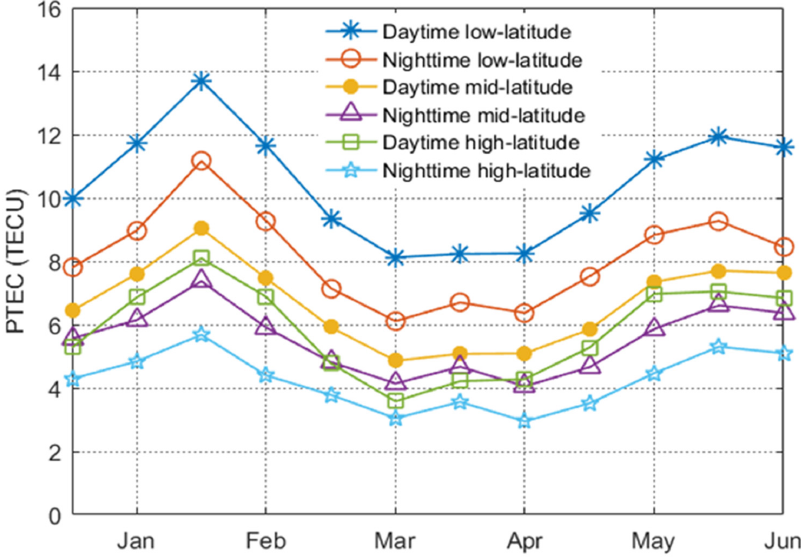
Figure 10. Monthly mean daytime and nighttime PTEC in different geomagnetic latitudes in